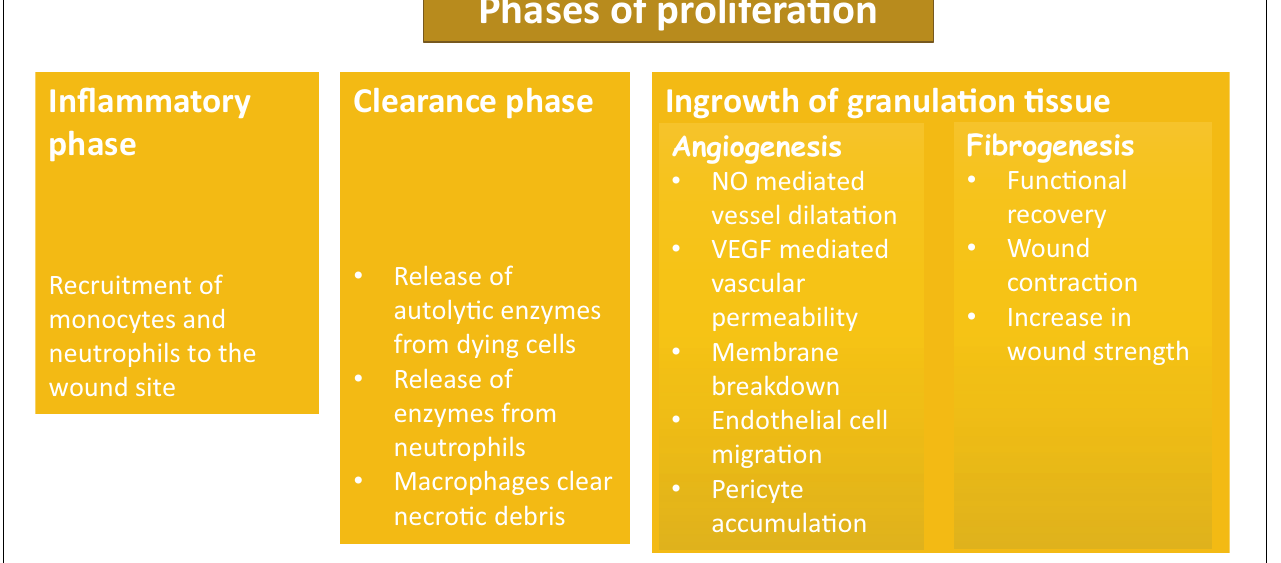
FIGURE 3 | Phases of proliferation and granulation.